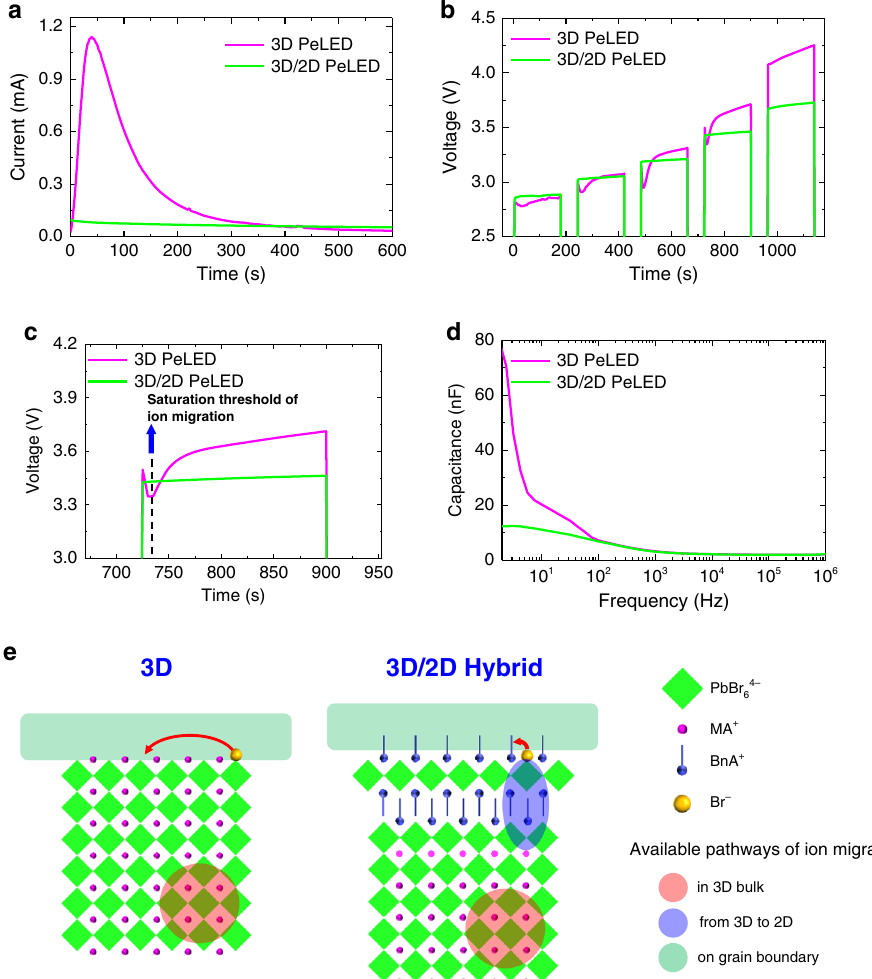
Fig. 7 In fl uence of ion migration in perovskites on PeLEDs. a Current behaviour of PeLEDs as a function of time under constant voltage of 3.5 V. b Voltage behaviour of PeLEDs under increasing step constant current of 0.16, 0.22, 0.44, 1.11, 2.22 mA cm − 2 from the left column to the right in a sequence. c Magni fi ed version of one step showing the discrepancy in the voltage behaviour between 3D PeLED and 3D/2D hybrid PeLED. d Capacitance-frequency curve of PeLEDs. e Schematic of possible ion migration pathways in 3D and 3D/2D hybrid perovskites and ef fi cient restriction of ion migration owing to the BnA which has retardation effect of